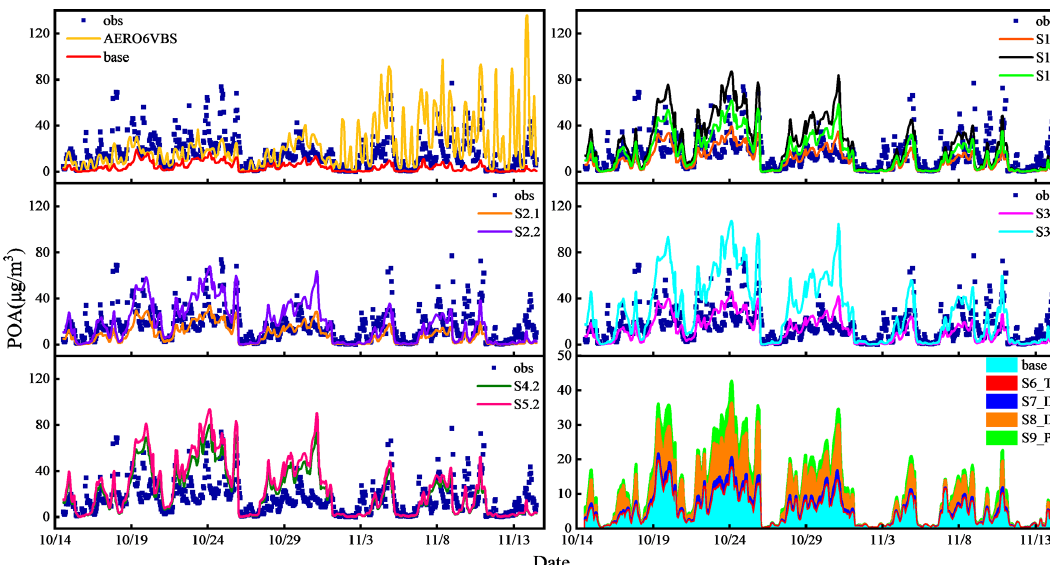
Figure 4. The observed and simulated hourly POA concentrations during the episode from 14 October to 14 November 2014 at the Beijing site for the sensitivity cases, as summarized in Table